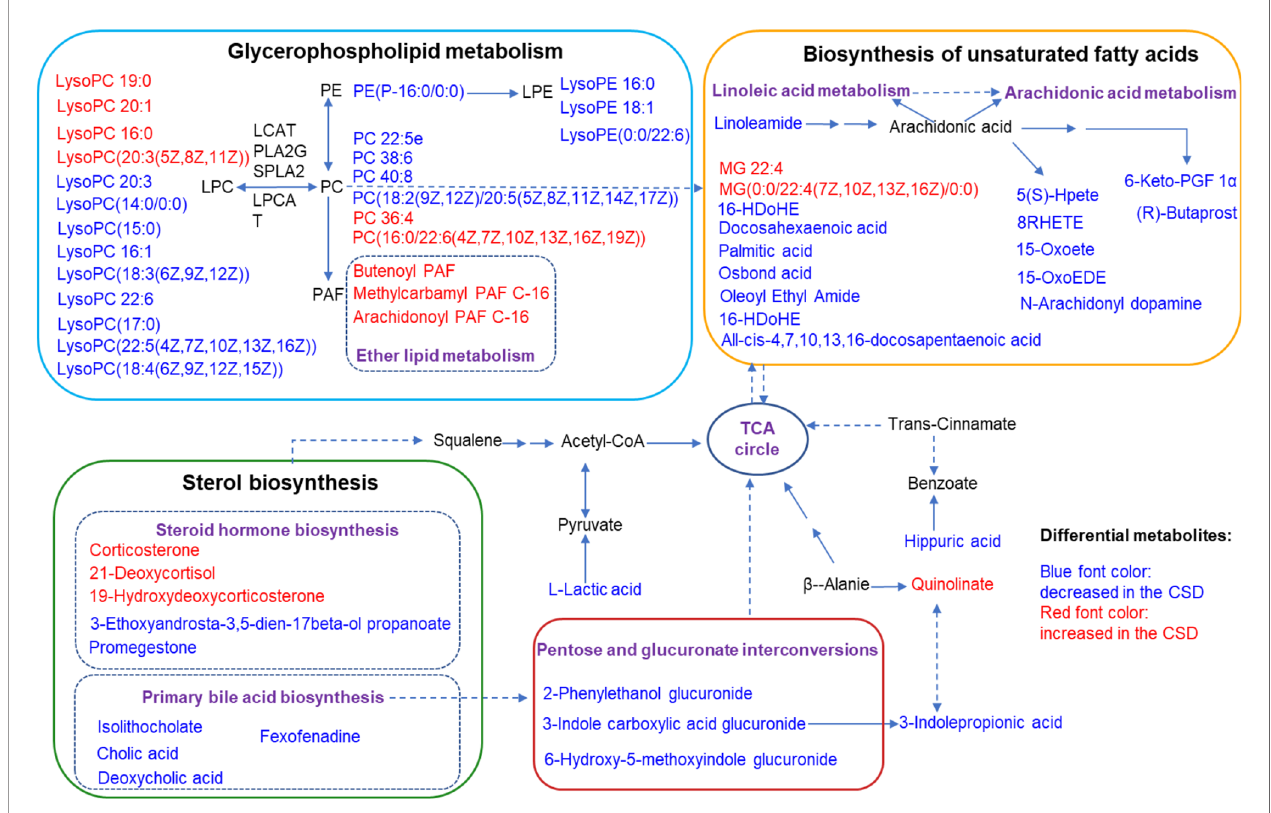
FIGURE 6 | Summaries of metabolic pathways based on KEGG database. Blue font color represents the metabolites decreased in CSD rats, and red font color represents the metabolites increased in CSD